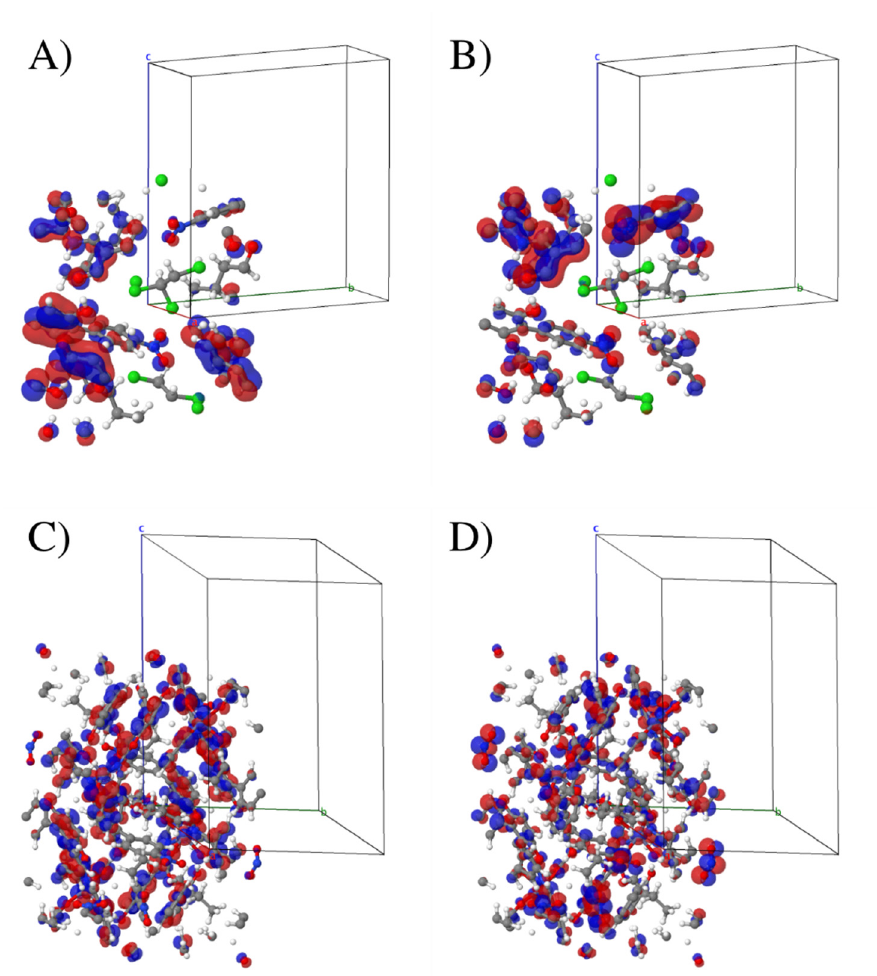
Figure 6. Orbital isodensity plot of the L system for HOCO ( A ) and LUCO ( B ), and of L 2 Zn for HOCO ( C ) and LUCO ( D ). The isolevel was set to 0.01 |e|/Bohr. The asymmetric unit cells had 142 and 500 atoms for the L and L 2 Zn compounds, respectively.